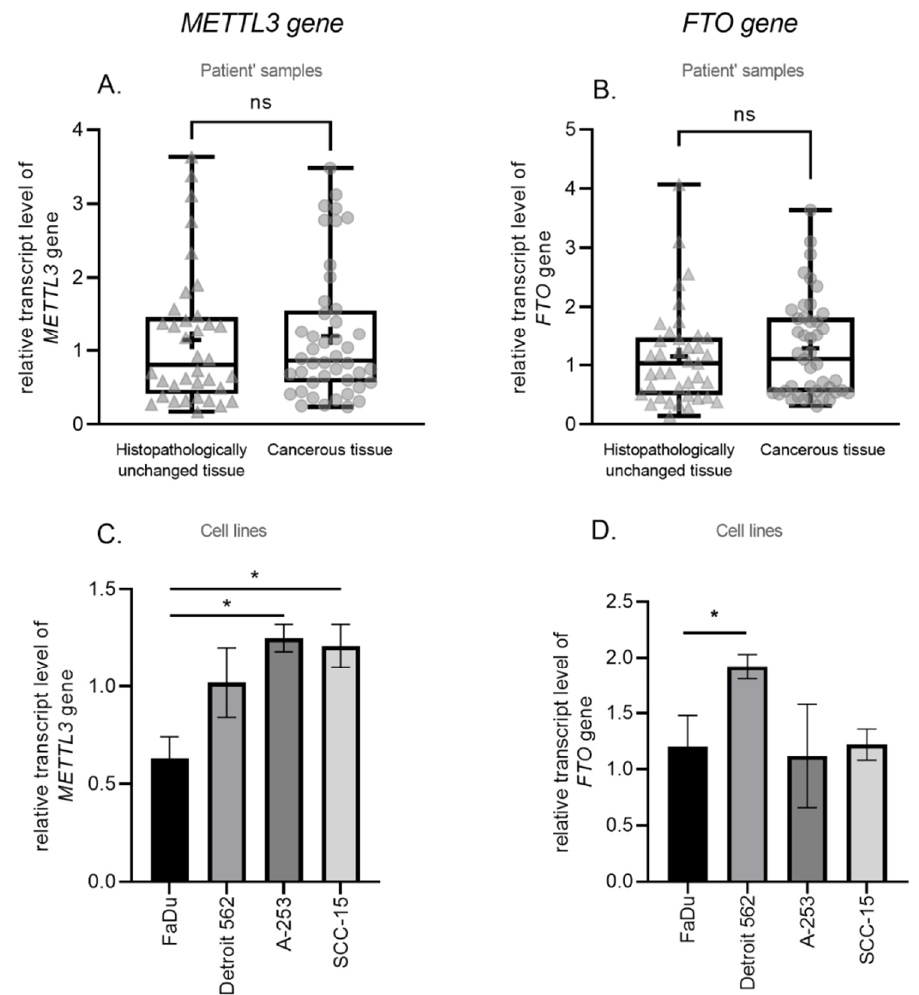
Figure 2. The transcript level of ( A ) METTL3 and ( B ) FTO genes in cancerous and histopathologically unchanged tissues from HNSCC patients and ( C , D ) cell lines. ns (non-significant), + (mean value), * ( p ≤ 0.05).